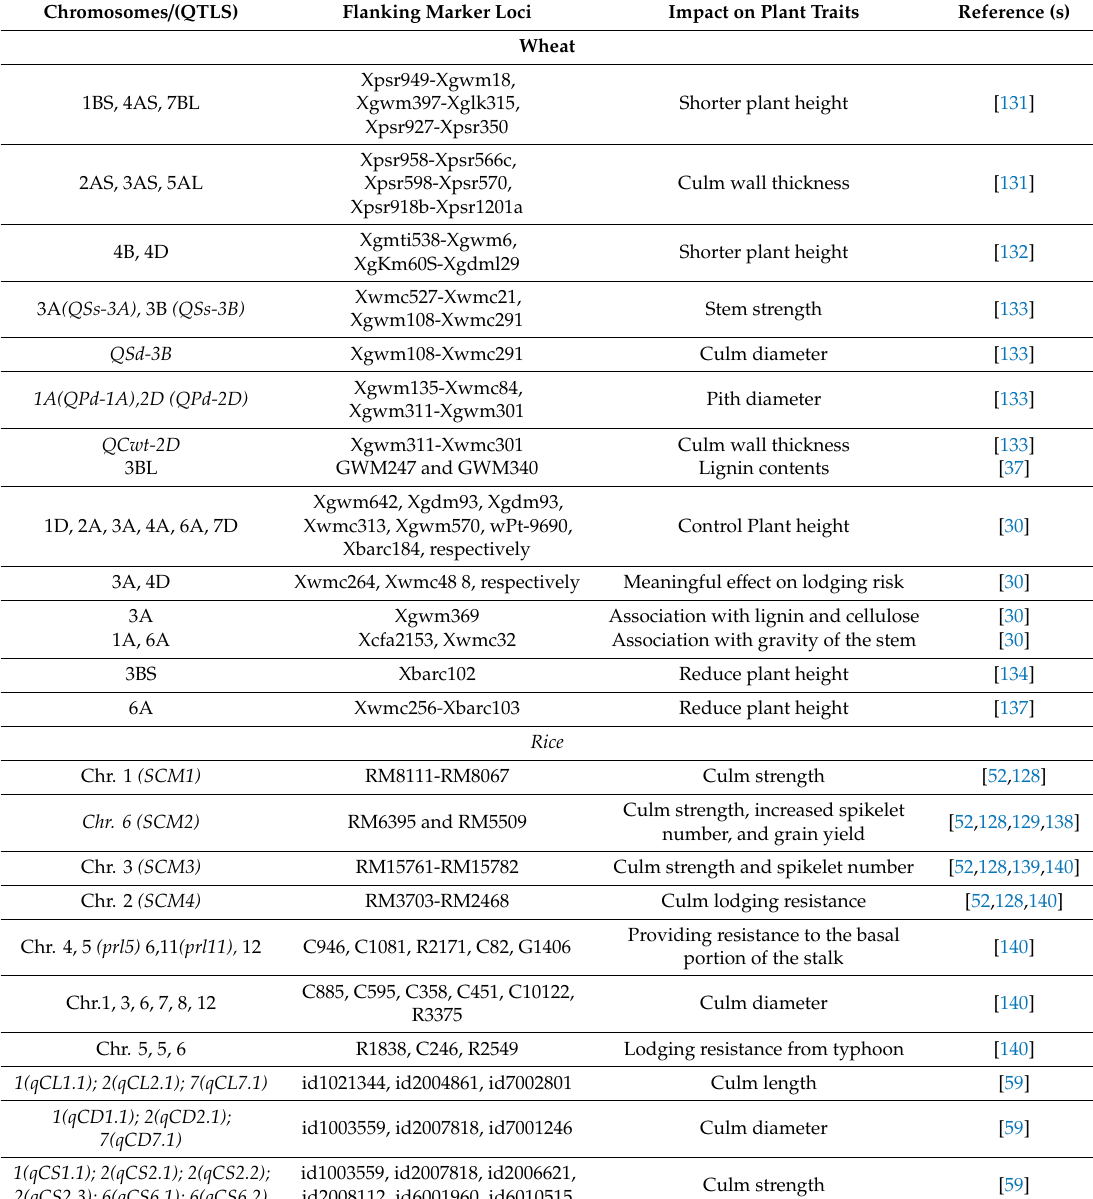
Table 2. Quantitative trait loci (QTLs) for plant height and culm thickness in wheat and rice. Chromosomes /